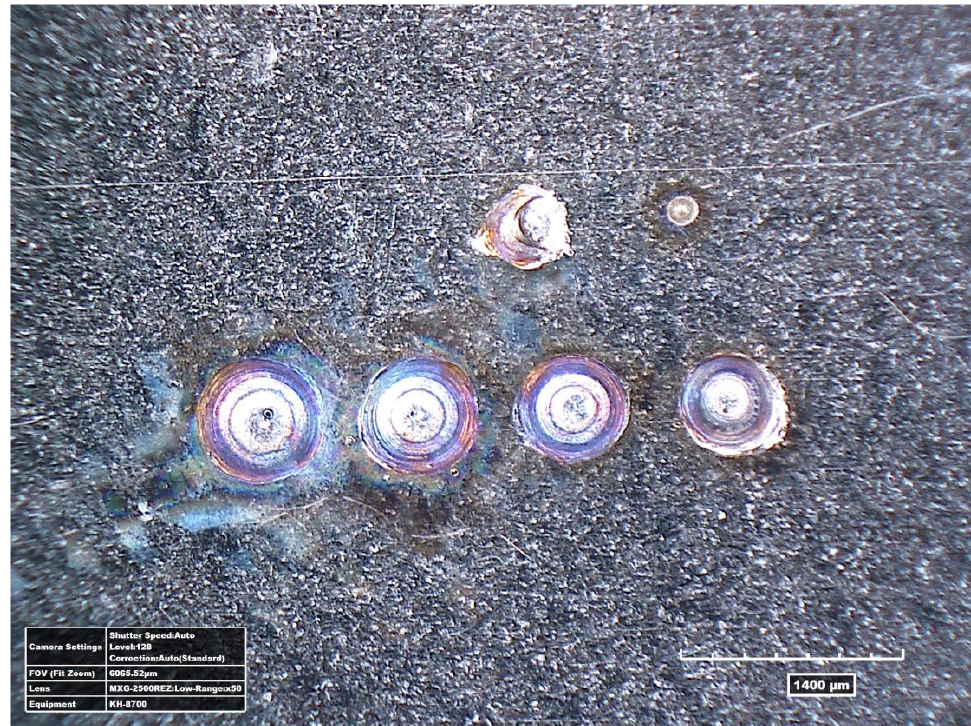
Figure 4: Selection of welding parameters for nickel foil. View of the weld root for the following pulse lengths (from left to right): 8ms, 7ms, 6ms and 5ms.